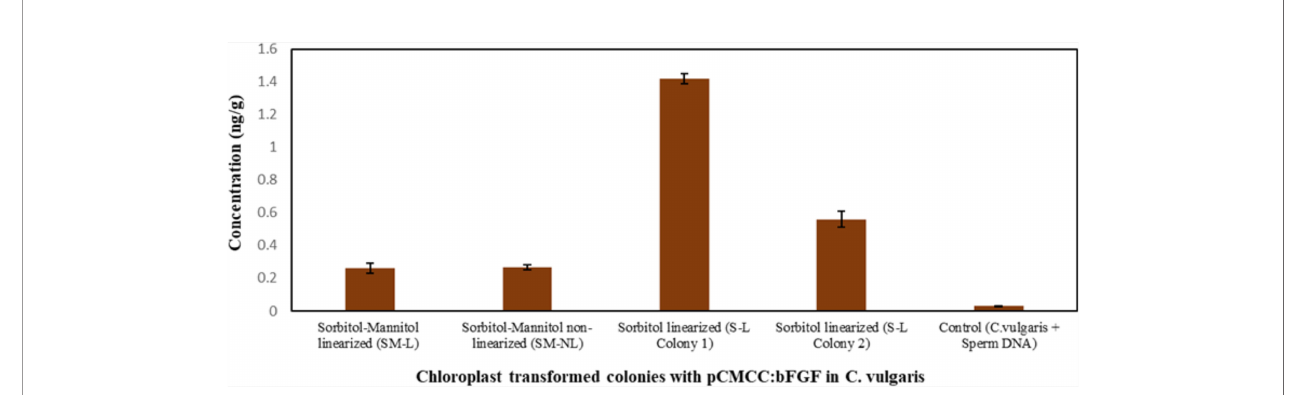
FIGURE 5 | The expression levels of bFGF in chloroplast-transformed Chlorella vulgaris cultures were measured by ELISA. C. vulgaris was transformed with pCMCC:bFGF plasmid using sorbitol – mannitol and sorbitol buffers by electroporation. Line 1, SM-L colony; lane 2, SM-NL colony; lane 3, S-L colony 1; lane 4, S-L colony 2; control, C. vulgaris + sperm DNA. The result was presented on the fresh weight basis. The data are expressed as mean ± standard deviation of three biological replicates with each sample (1:1 dilution) obtained in independent